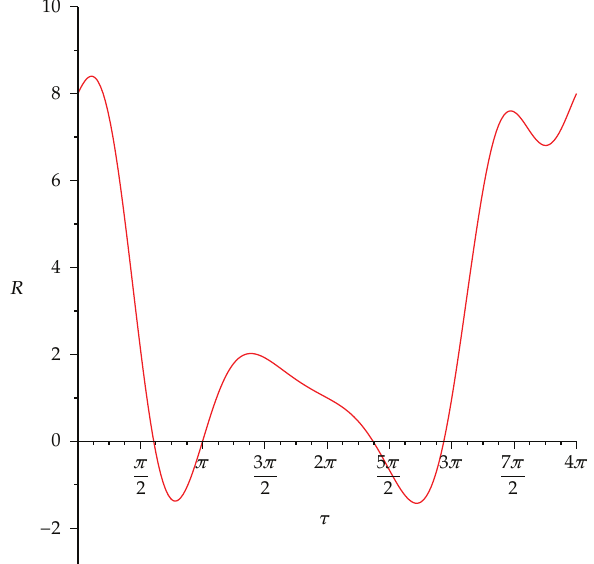
Figure 32: The evolution of the R with respect of the cosmic time τ for (cid:2) 5.24 (cid:3) .